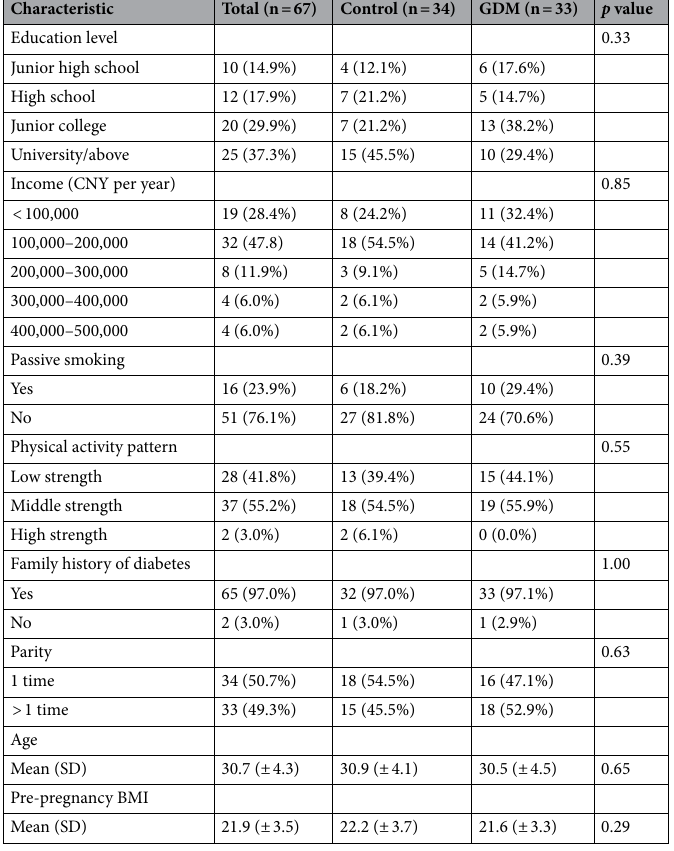
Table 1. Basic characteristics of control and GDM pregnant women. p value of age and pre-pregnancy BMI were calculated by Mann–Whitney U test; p value of education level, income, passive smoking, physical activity pattern, family history of diabetes and parity were calculated by Pearson Chi-square